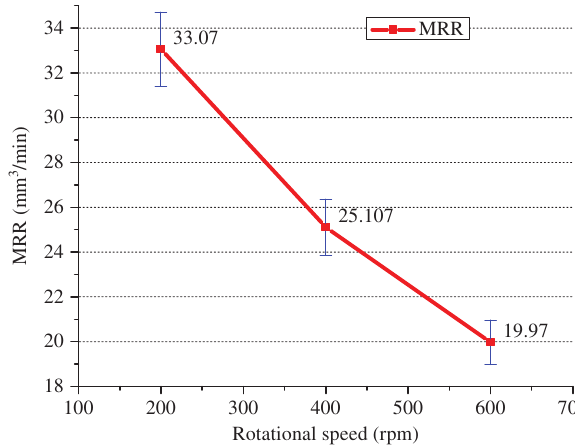
Figure 7: MRR vs. rotation